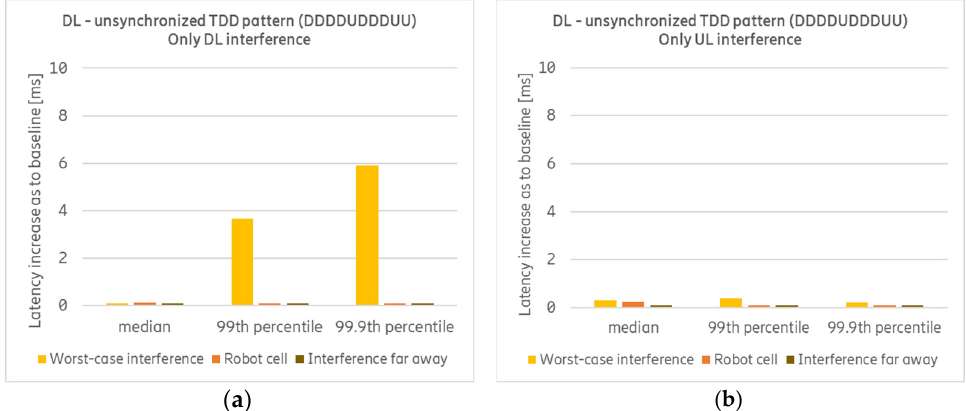
Figure 8. Increase in DL latency compared to the respective baseline for unsynchronized TDD pat- tern (indoors: DDDDUDDDUU, outdoors: DDDDU) and different indoor/outdoor UE deployment locations. ( a ) Result for only DL interference (near–far interference). ( b ) Result for only UL interference (cross-link interference).